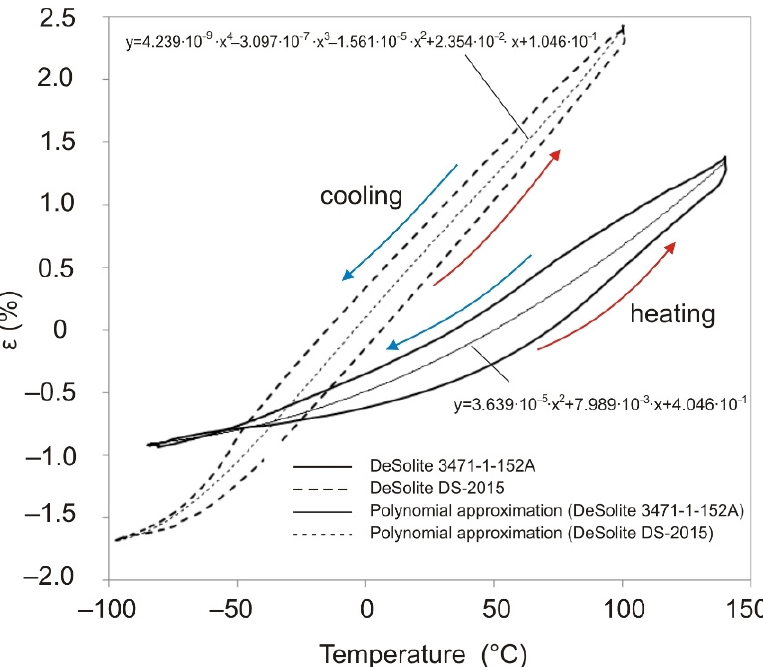
Figure 4. Temperature dependence of deformation for DeSolite 3471-1-152A (dashed line) and DeSolite DS-2015 (solid line) polymers, cooling/heating rate 2 °C/min. Polynomial approximation of the temperature dependence of the averaged strain values taken on heating and cooling.